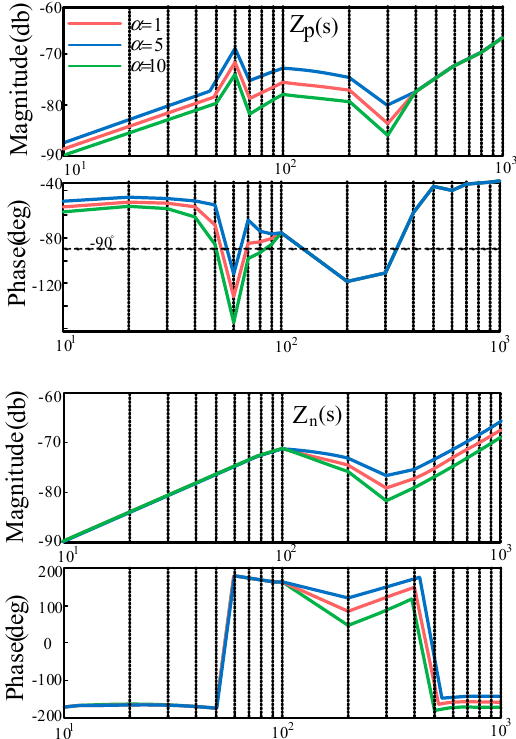
Figure 10. Frequency responses of output impedance as α changes.